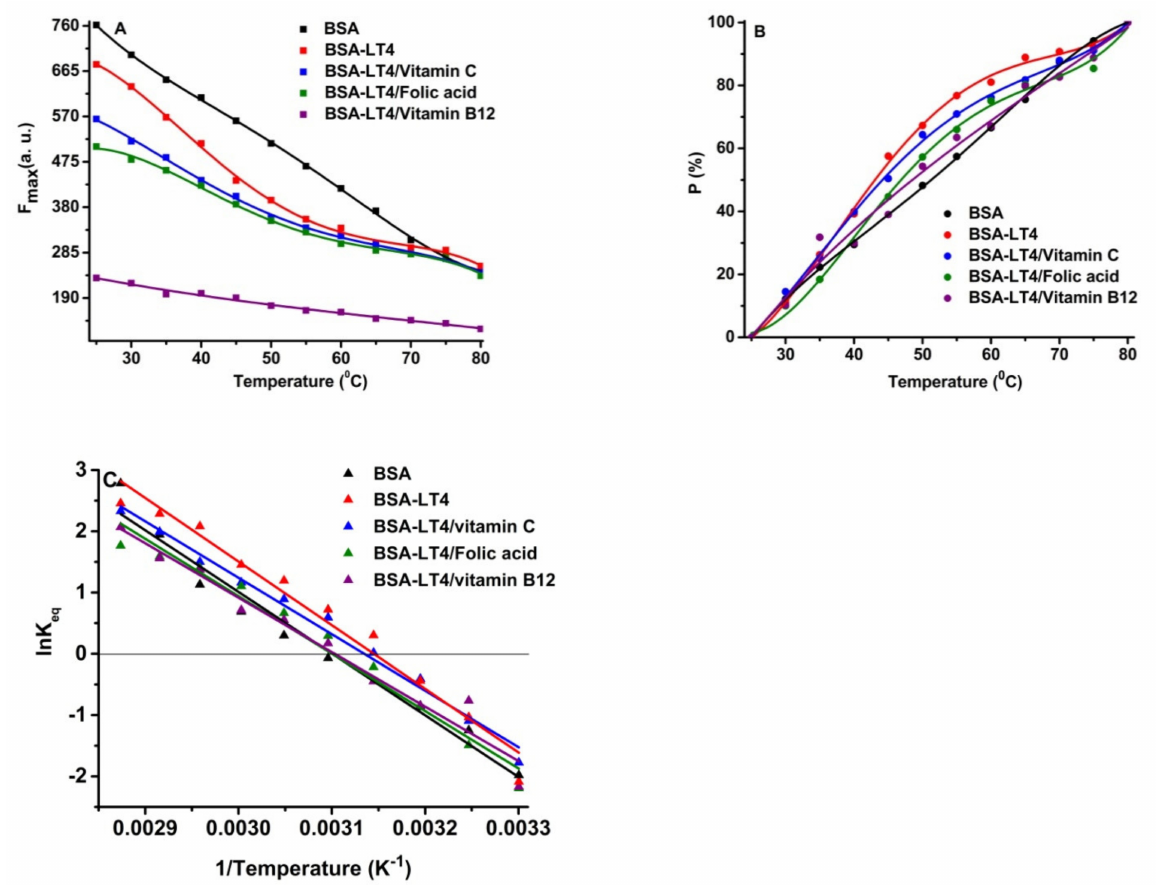
Figure 7. ( A ) The fluorescence maxima during the thermal denaturation processes of BSA (3 µ M), BSA-LT4 ([LT4] = 3 µ M), and BSA-LT4/vitamins ([vitamin] = 10 µ M). ( B ). The percentage (P) of BSA denaturation as a function of temperature. ( C ) Graphical representation of ln K eq vs. temperature. Considering that the process of thermal denaturation of BSA-LT4 assumes the existence of the model in two states, N —native (folded) and D —denatured (unfolded), the balance of this process will be established according to the relation (6):